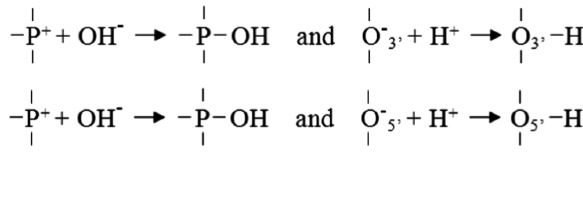
Figure 27 Scheme of electron-vibration-rotation levels of intramolecule transitions in compound organic molecules and singlet-singlet energy transfer between donor and